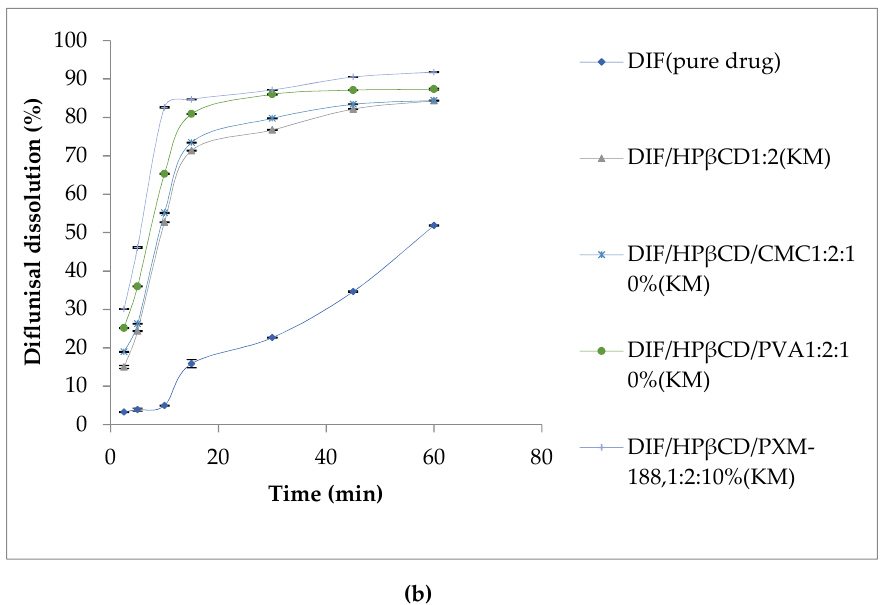
Figure 2. Mean dissolution profiles of DIF, binary and ternary systems with βCD ( a ) and HPβCD ( b ). Mean ± SD, N = 3. Table 3. The dissolution parameters of DIF, binary and ternary systems. Mean ± SD, N = 3. Samples